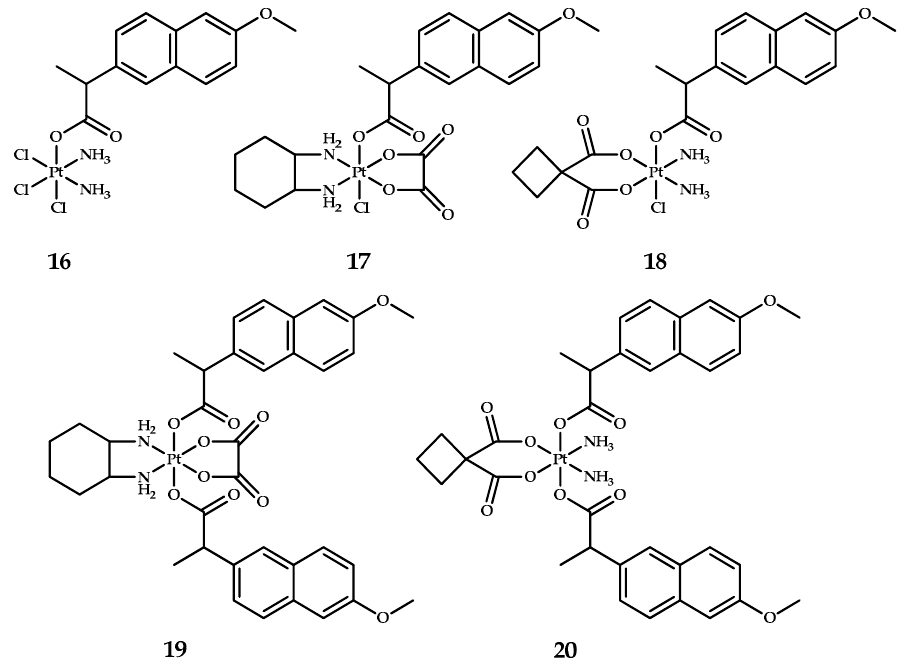
Figure 9. Naproxen-containing platinum(IV) prodrugs based on cisplatin 16 , carboplatin 17 and oxaliplatin 18 and di-carboxylated complexes based on oxaliplatin 19 and carboplatin 20 . The antiproliferative activity of complexes 16 – 20 was evaluated by MTT assay on four malignant cell lines: A549, A549R (cisplatin-sensitive and cisplatin-resistant lung carcinoma, respectively), SKOV-3 (ovarian cancer), and CT-26 (colon cancer) in comparison with LO-2 (a human normal liver cell line) (Table 9). Prodrugs 19 and 20 , with two naproxen moieties in axial positions, showed lesser activity than the corresponding mono-substituted complexes 17 and 18 , respectively. The selectivity index (SI) was defined as the ratio of IC 50 values obtained on the normal cell line LO-2 to the average of the IC 50 values obtained on tumor cells. Cisplatin and cisplatin-based prodrug 16 showed the worst SIs of 0.5